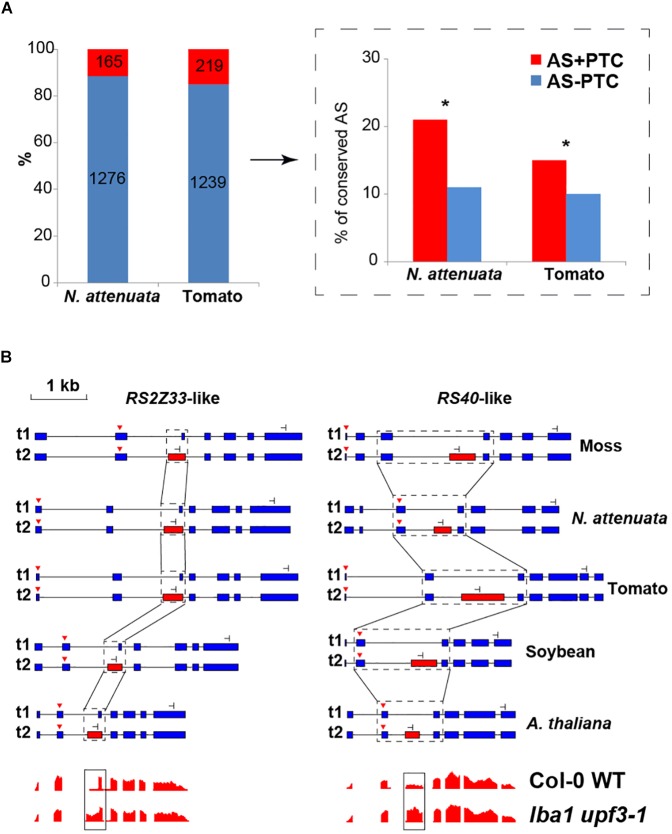
The conservation of AS between AS+PTC and AS-PTC. (A) The number and relative portions of AS±PTC in N. attenuata and tomato. The insert indicated by the black arrow depicts the percentage of AS+PTC and AS-PTC that are conserved between N. attenuata and tomato. Asterisks indicate the significant difference between two AS groups as determined by Fisher’s exact test (P < 0.05). (B) Conserved AS between moss and eudicots in serine/arginine-rich splicing factor RS2Z33-like and RS40-like gene. The diagrams of the structure of transcripts generated by the AS in all five species, the dominant and minor transcripts are represented by t1 and t2, respectively. Constitutive exons are represented by blue boxes, alternatively spliced exons are represented by red boxes and introns are represented by black solid lines. The black dotted boxes highlight the conserved AS and the start and stop codons are shown as red triangles and stop signs, respectively. The diagrams in the bottom panel showed the relative reads coverage of AtRS2Z33 and AtRS40 exons in wild-type plant and lba1 upf3-1 double mutants. The black box highlights the coverage of the spliced region which is significantly increased in lba1 upf3-1 double mutants (The diagrams are modified based on the data shown in http://gbrowse.cbio.mskcc.org/gb/gbrowse/NMD201).